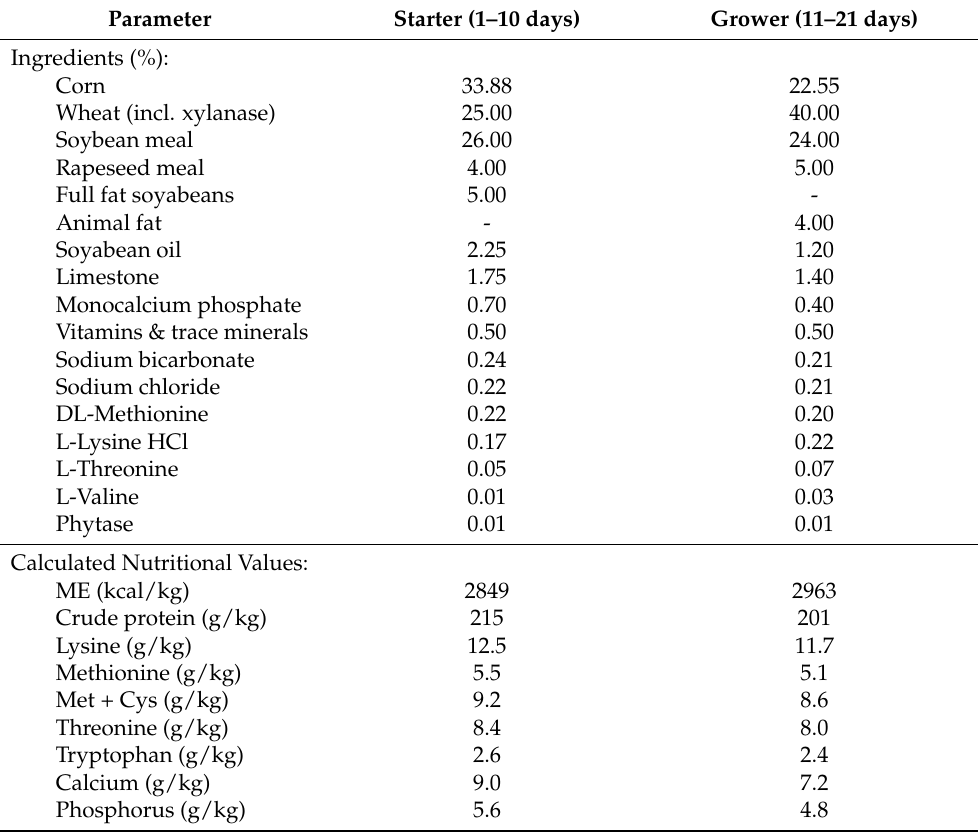
Table 2. Details of the basal diets used for the gut mechanism